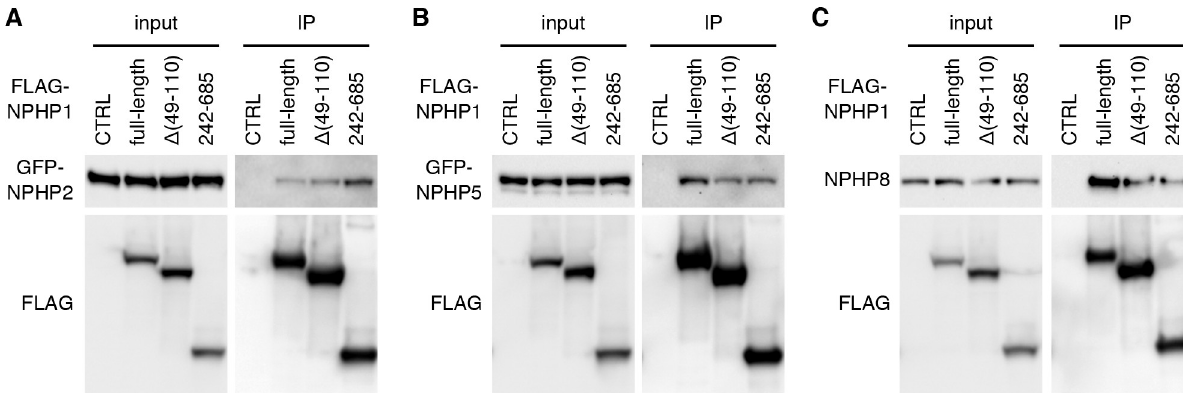
Fig 6. Interaction of NPHP1 Δ (49–110) with other NPHP proteins. Expression vectors of FLAG-tagged NPHP1 (full-length), NPHP1 Δ (49–110), and NPHP1 aa242-685 were co-transfected with either pEGFP-NPHP2 (A) or pEGFP-NPHP5 (B) to 293T/17 cells, and protein extracts were subjected to immunoprecipitation (IP) with anti-FLAG antibodies. Empty vectors were used as a negative control (CTRL). For NPHP8 (C), endogenous NPHP8 was probed.